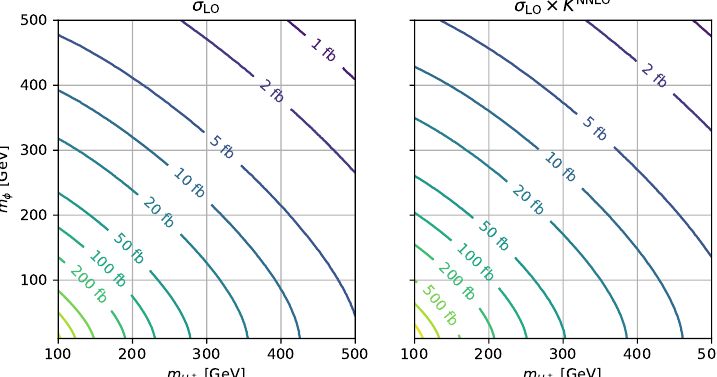
Figure 8. Left : LO cross section for pp → H ± φ production (with φ = h BSM , A ) as a function of m and m . Right : same as left but the LO cross section multiplied with NNLO K -factor is φ H ± shown. Both figures assume exact